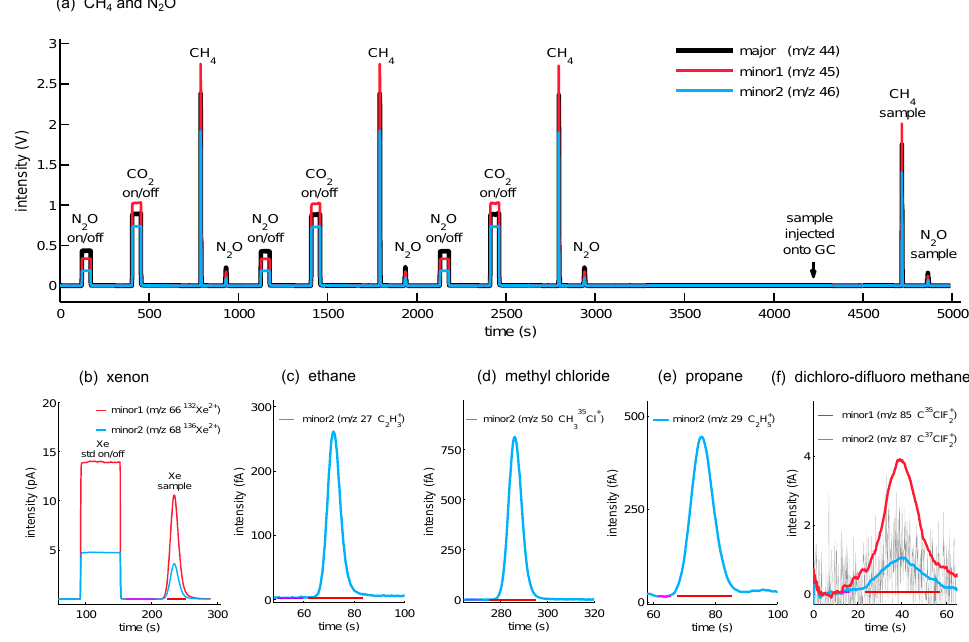
Figure 3. Chromatograms illustrating the sequence of runs and detected gas species at the respective focus settings of the ion source for an Antarctic ice core sample. The order from (a) to (f) follows the increasing retention time starting with CH 4 and ending with CCl 2 F 2 . (a) CH 4 –N 2 O-run consisting of rectangular on/off peaks for N 2 O and CO 2 admitted by the reference gas box, Gaussian peaks for CH 4 and N 2 O injected via valves 3 and 4 (Fig. 1), and sample peaks for CH 4 and N 2 O at the end of the run. (b) Xe run consisting of a rectangular on/off Xe peak as reference and the following Xe sample peak. (c–f) show the chromatograms for the organic trace gas species ethane, methyl chloride, propane and dichlorodifluoromethane (CCl 2 F 2 ) , respectively, eluting at higher GC temperatures. All chromatograms reflect species concentrations of the ice, except for CCl 2 F 2 , which serves as an indicator of contamination with modern ambient air. To better visualise the small CCl 2 F 2 intensities from the highly amplified minor1 and minor2 cups, the red and blue lines here represent a moving average of 1s; the minor2 raw signal at 0.1s resolution is shown as a grey